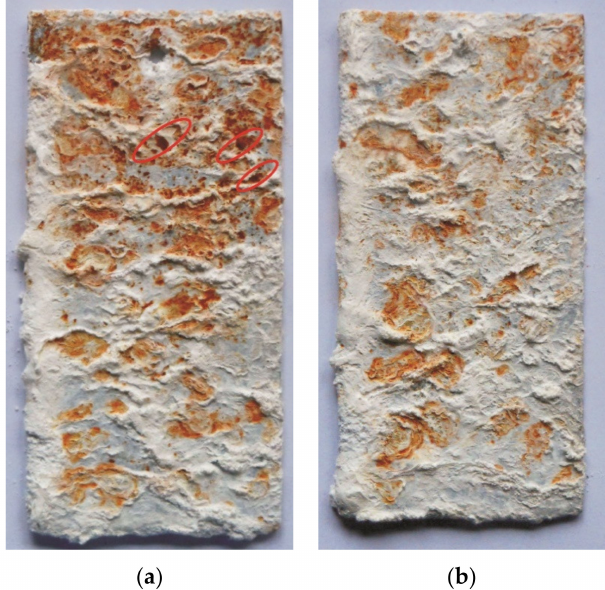
Figure 6. The outlook of the surface of coatings made in: ( a ) Zn-AlNiBiSn and ( b ) Zn-AlNi bath after 1000 h of research lasting in neutral salt spray (NSS)